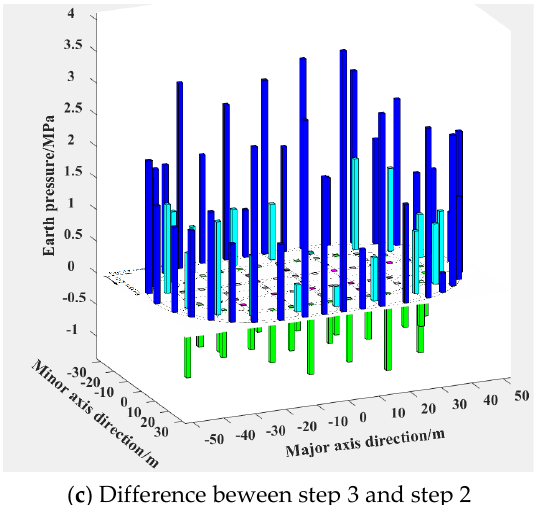
Figure 13. Distribution of earth pressure difference between adjacent soil excavation steps by numerical analysis (the color is for the same meaning in the Figure 12).